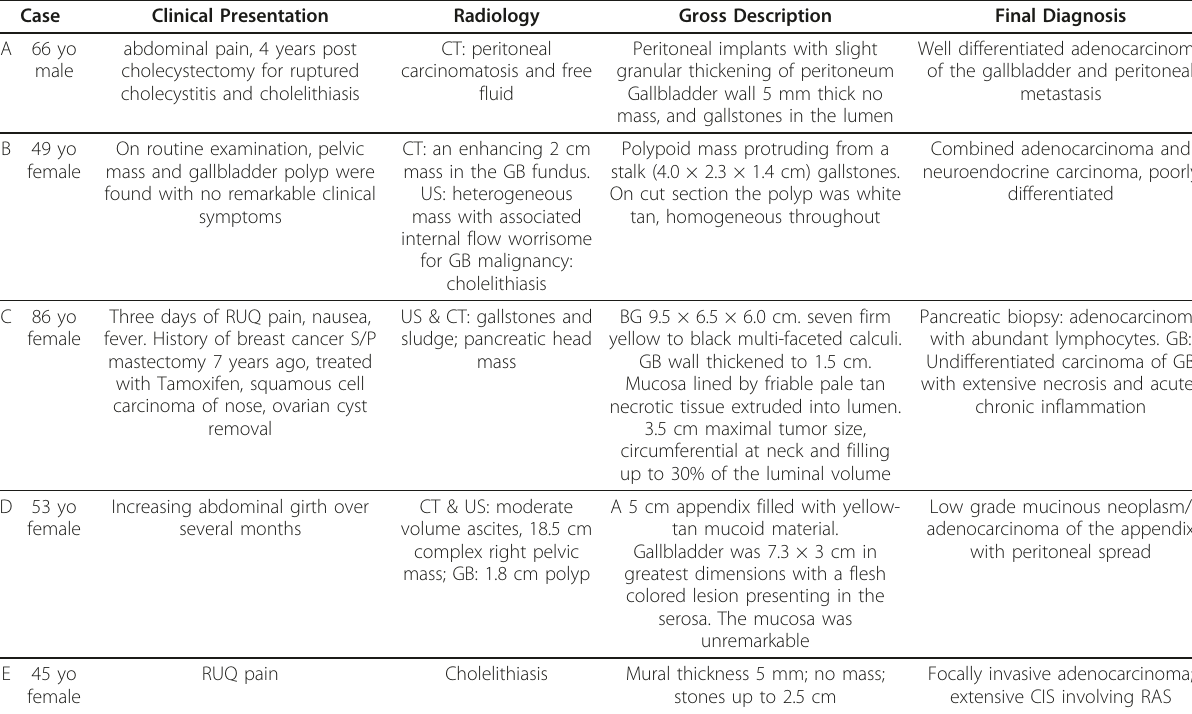
Table 2 Summary of case details in problematic cases: